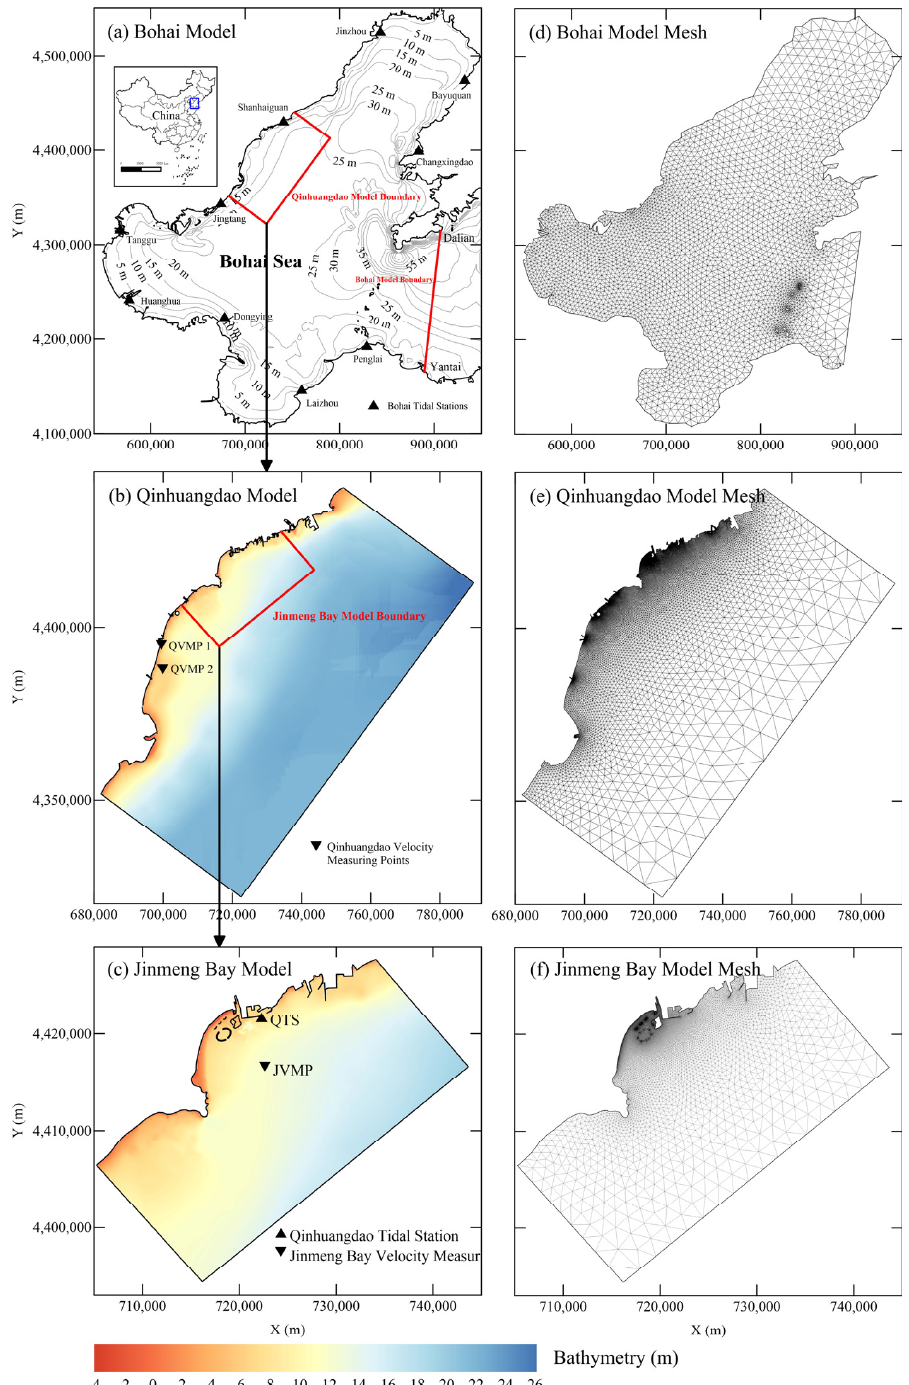
Figure 2. Computational domains with bathymetry and meshes of the ( a , d ) Bohai model; ( b , e ) Qinhuangdao model; and ( c , f ) Jinmeng Bay model. Red lines represent the open boundaries of the three models.